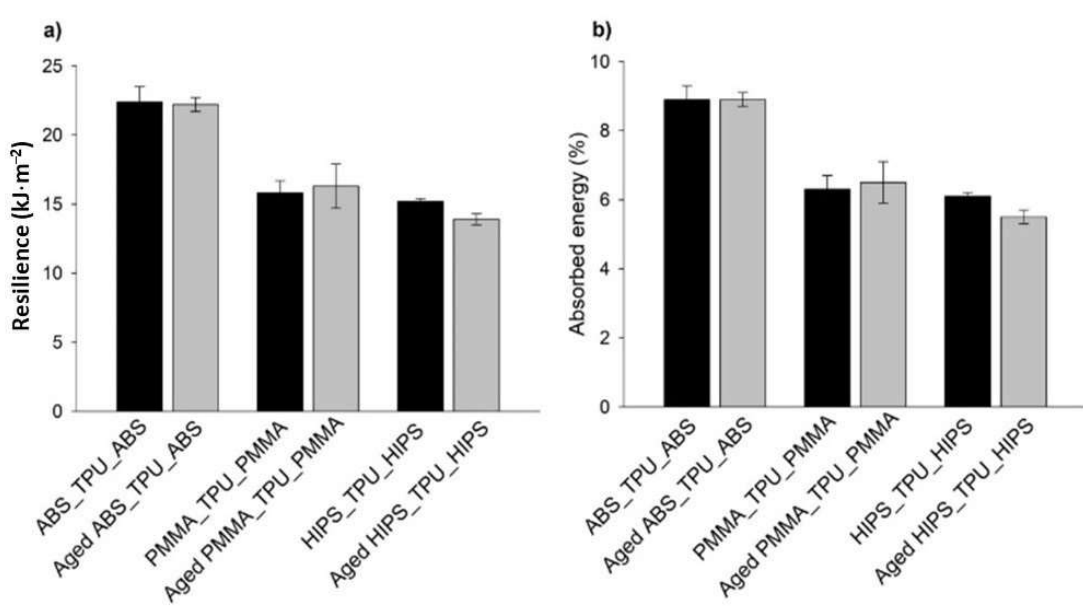
Figure 8. ( a ) Resilience and ( b ) absorbed energy, which were determined by transversal impact tests.